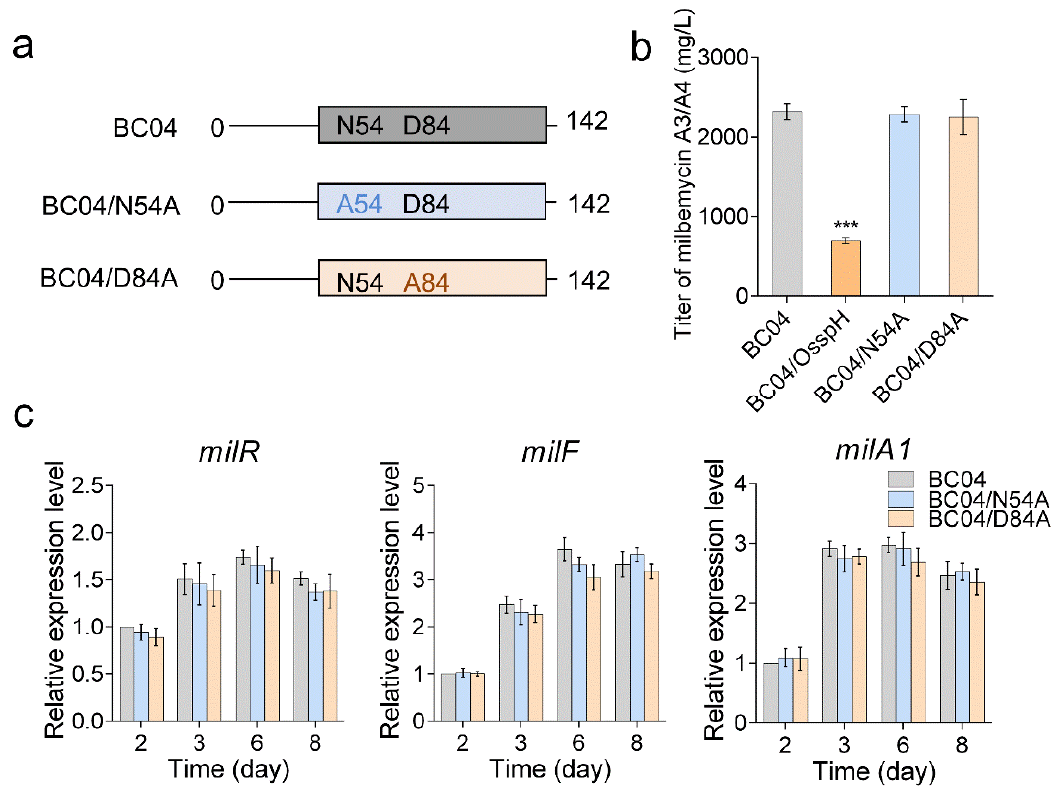
Figure 5. Effects of site-directed mutagenesis in the HATPase domain of SspH on its function. ( a ) Diagrams of site-directed mutation in the HATPase domain. A54, Asn54 was mutated to Ala; A84, Asp84 was changed to Ala. ( b ) Titers of milbemycin A3/A4 in strains BC04, BC04/OsspH, BC04/N54A and BC04/D84A. ( c ) qRT-PCR analysis of the transcriptional levels of milR , milF and milA1 in BC04, BC04/N54A and BC04/D84A. The expression of each gene in BC04 on day 2 was